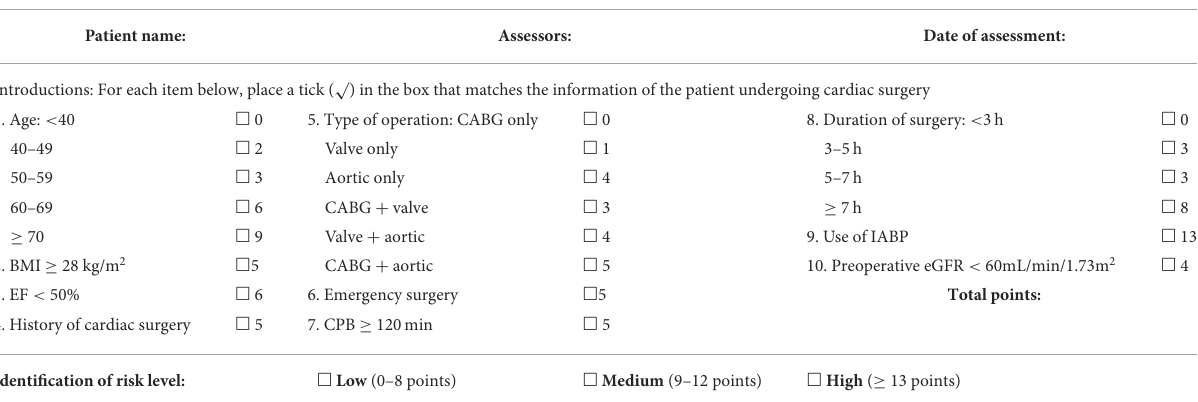
TABLE 5 Clinical risk assessment form for delayed extubation following cardiac surgery. Clinical risk assessment